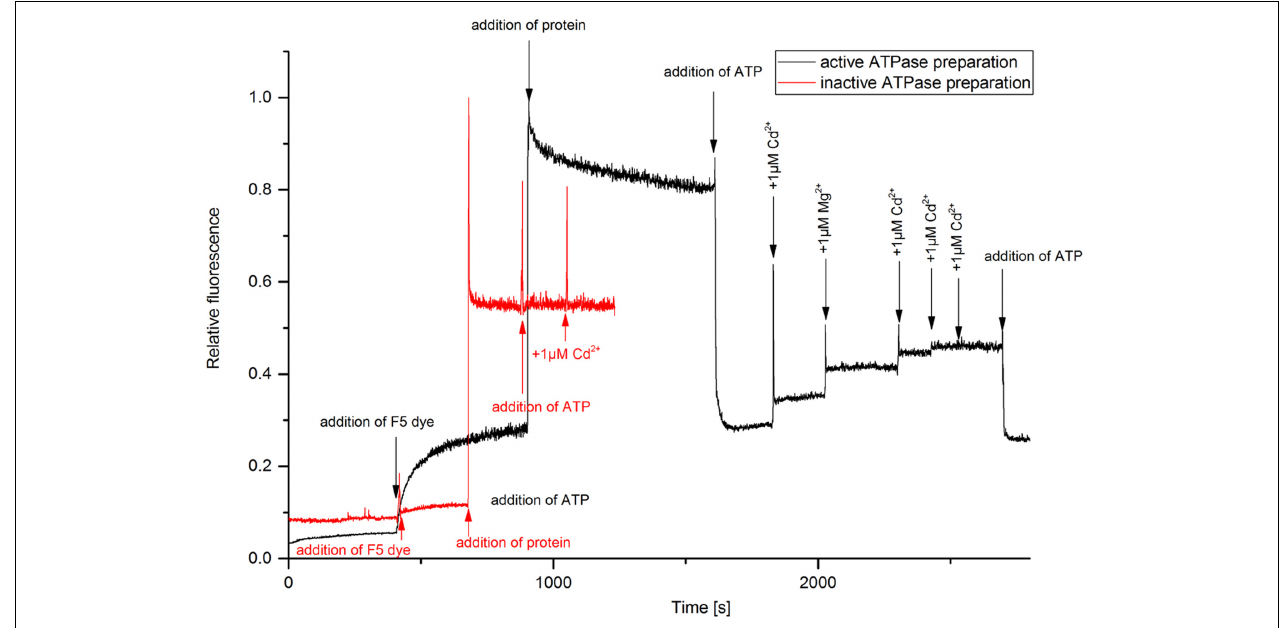
FIGURE 2 | Analysis of metal binding to NcHMA4 protein through the electrochromic fluorescent dye F5. Fluorescence kinetic response of the dye inserted together with NcHMA4 into lipid vesicles to subsequent addition of 5 mM ATP and 1 µ M Cd 2 + per step. The final concentrations of dye and protein were 0.2 µ M, 0.3 µ g/ml, respectively. The figure is representative for three independent